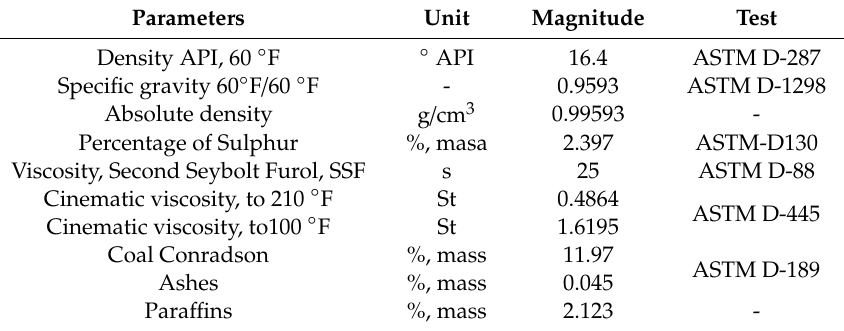
Table 17. Characterization parameters of heavy crude.